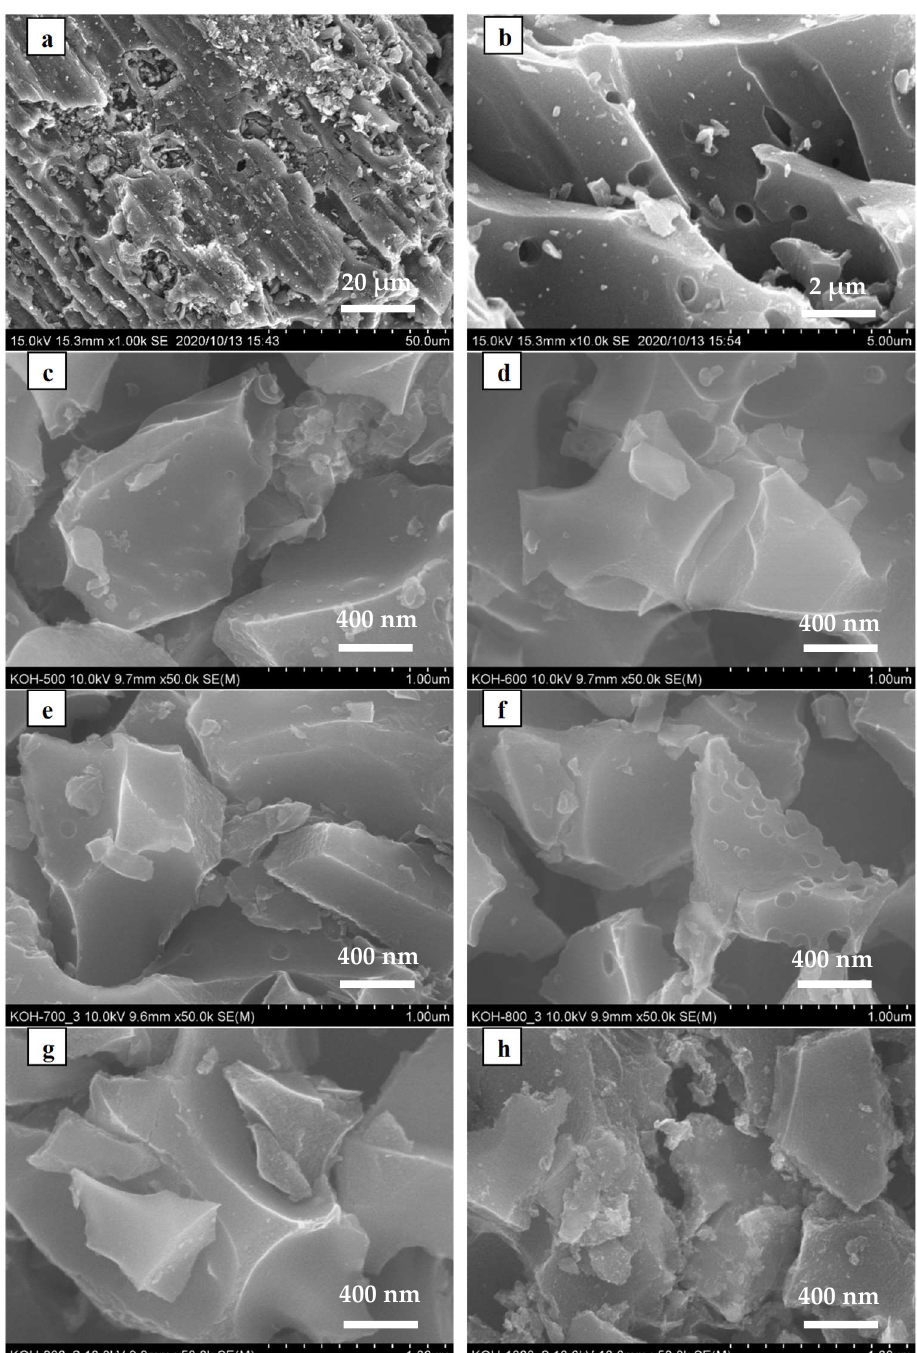
Figure 1. Scanning electron microscopy images of ( a ) ( b ) char carbonized at 900 °C and ACs after activation at ( c ) 500 °C, ( d ) 600 °C, ( e ) 700 °C, ( f ) 800 °C, ( g ) 900 °C and ( h ) 1000 °C.